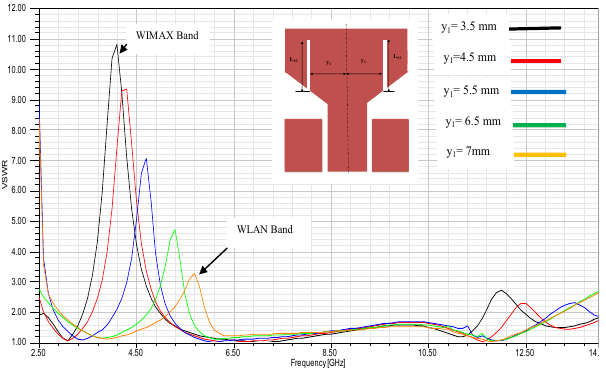
Figure 7: Simulated VSWR characteristic for various values of L S1 (a) and y (b) for antenna-2 (Figure 4).